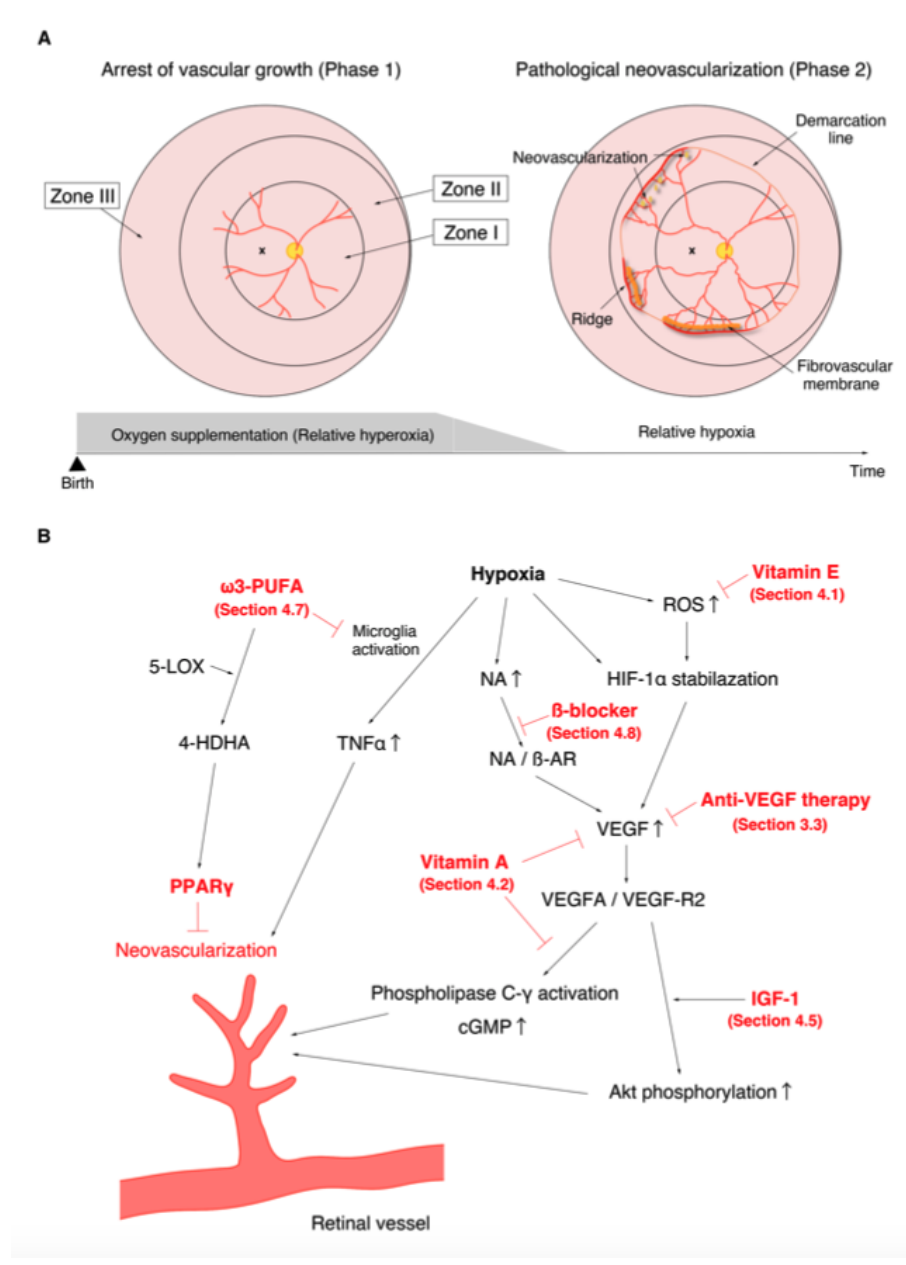
Figure 1. Phases of retinopathy of prematurity (ROP) and the action mechanisms of drugs with confirmed therapeutic effects in the treatment of ROP in previous clinical trials and meta-analysis. ( A ). Relative hyperoxia in phase 1 arrests vascular growth (left). Relative hypoxia in phase 2 causes pathological neovascularization (right). ( B ). Molecular mechanisms of neovascularization. The various points at which anti-vascular endothelial growth factor therapy (Section 3.3), vitamin E (Section 4.1), vitamin A (Section 4.2), insulin-like growth factor-1 (Section 4.5), ω 3-polyunsaturated fatty acids (Section 4.7), and β -blockers (Section 4.8) act are shown in